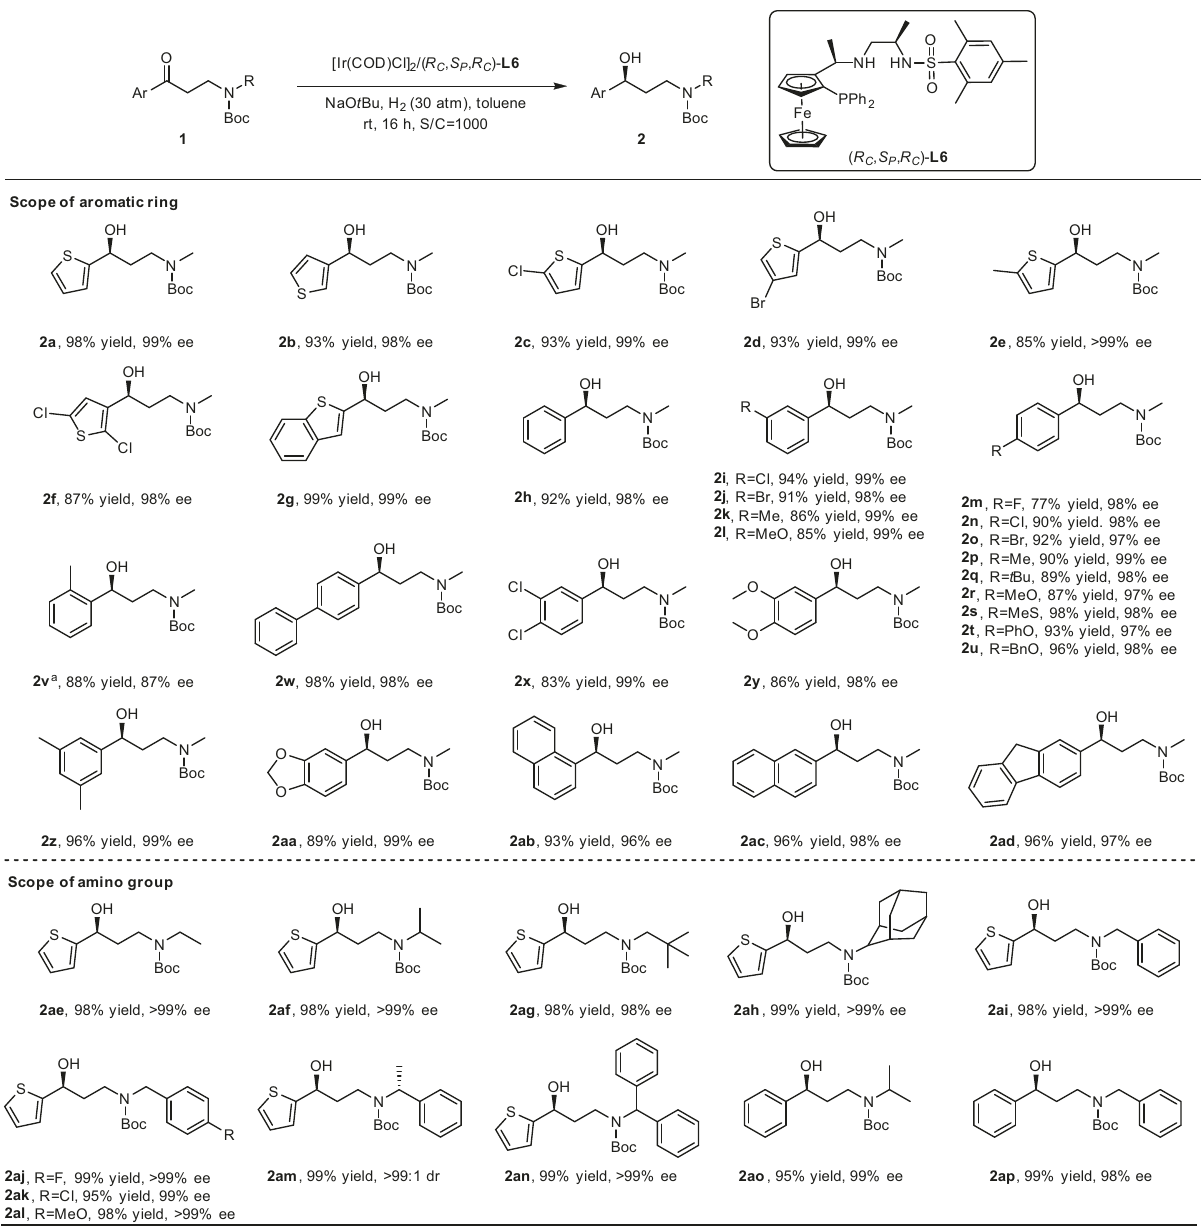
Fig. 2 Asymmetric hydrogenation of various N-Boc- β -amino ketones with Ir – (RC,SP,RC)-L6 catalyst. Reaction conditions: 0.4 mmol scale, 0.05 mol% [Ir(COD)Cl] 2 , 0.105 mol% ( R C , S P , R C )- L6 , 5 mol% NaO t Bu, 2.0 mL toluene, room temperature (25 – 30 °C). Isolated yields. The ee determined by HPLC. a at 60